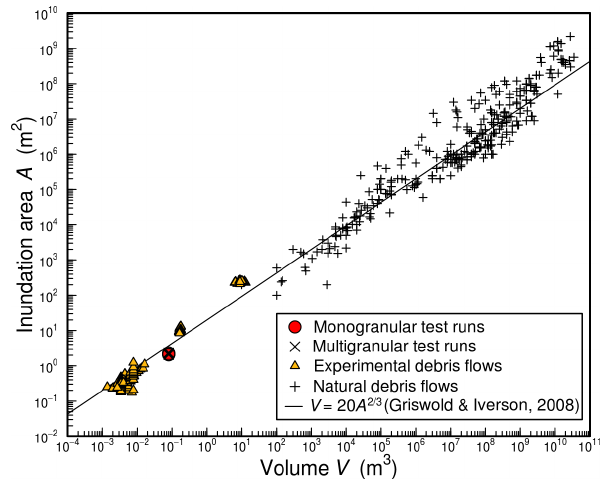
Figure 19. Debris-flow volume versus inundation area. Data con- cerning experiments ( n = 544) are from Liu (1996), Major (1997), D’Agostino et al. (2010), De Haas et al. (2015b), Hürlimann et al. (2015), and Baselt et al. (2022). Data concerning natural de- bris flows ( n = 323) are from Abele (1974), Li (1983), Crandell et al. (1984), Siebert (1984), Francis et al. (1985), Siebert et al. (1987), Hazlett et al. (1991), Hayashi and Self (1992), Siebe et al. (1992), Stoopes and Sheridan (1992), Iverson et al. (1998, 2015), Capra et al. (2002), Berti and Simoni (2007), Griswold and Iverson (2008), D’Agostino et al. (2010), Dufresne et al. (2019), Fan et al. (2019), and Friele et al. (2020). Note that the monogranular and multigran- ular test runs of this study are overlain in the log–log plane and that the flow volume was approximated as 0.08m 3 on the basis of the supplied sediment volume. The solid black line is the best-fit regres- sion curve ( V = 20 A 2 / 3 ) derived by Griswold and Iverson